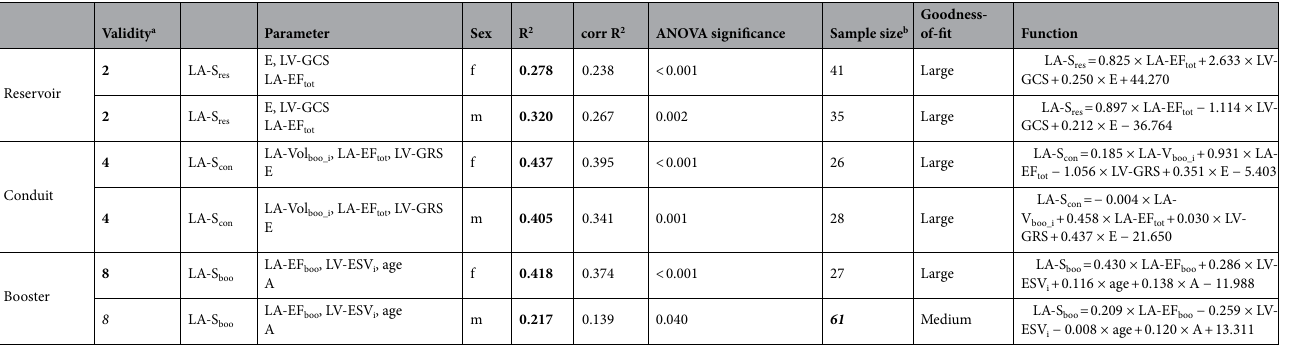
Table 7. Multilinear regression analysis to study multifactorial influences of left atrial strain. Analysis was done on subjects with heart rates between 60 and 75 bpm. A sub-selection is shown in this table. A comprehensive summary of all analyses is provided in the supplement online. In order to be able to carry out a multilinear regression analysis, it is mandatory to check the prerequisites in advance. These are (a) linear relationships between the variables, (b) no outliers, (c) independence of the residuals, (d) no multicollinearity, (e) homoscedasticity and (f) normal distribution. a Bold = prerequisites are met; italics = valid, but with fewer concerns due to the prerequisites (e.g. an outlier had to be removed or the independence of the residuals had not reached the optimal value of ~ 2 before the analysis); bolditalics = not valid due to violation of prerequisites. Number of females = 60; number of males = 46. Interpretation of |R 2 | according to Cohen. [Cohen, J. (1988). Statistical power analysis for the behavioral sciences (2nd ed.). Hillsdale, N.J.: L. Erlbaum Associates. Page 412 ff]. Small effect size: |R 2 |= 0.02; medium effect size |R 2 |= 0.13; large effect size |R 2 |= 0.26. b Sample size calculation see reference [Calculation according to Hemmerich, W. (2019). StatistikGuru: Poweranalyse und Stichprobenberechnung für Regression. Retrieved from https:// stati stikg uru. de/ rechn er/ power analy se-